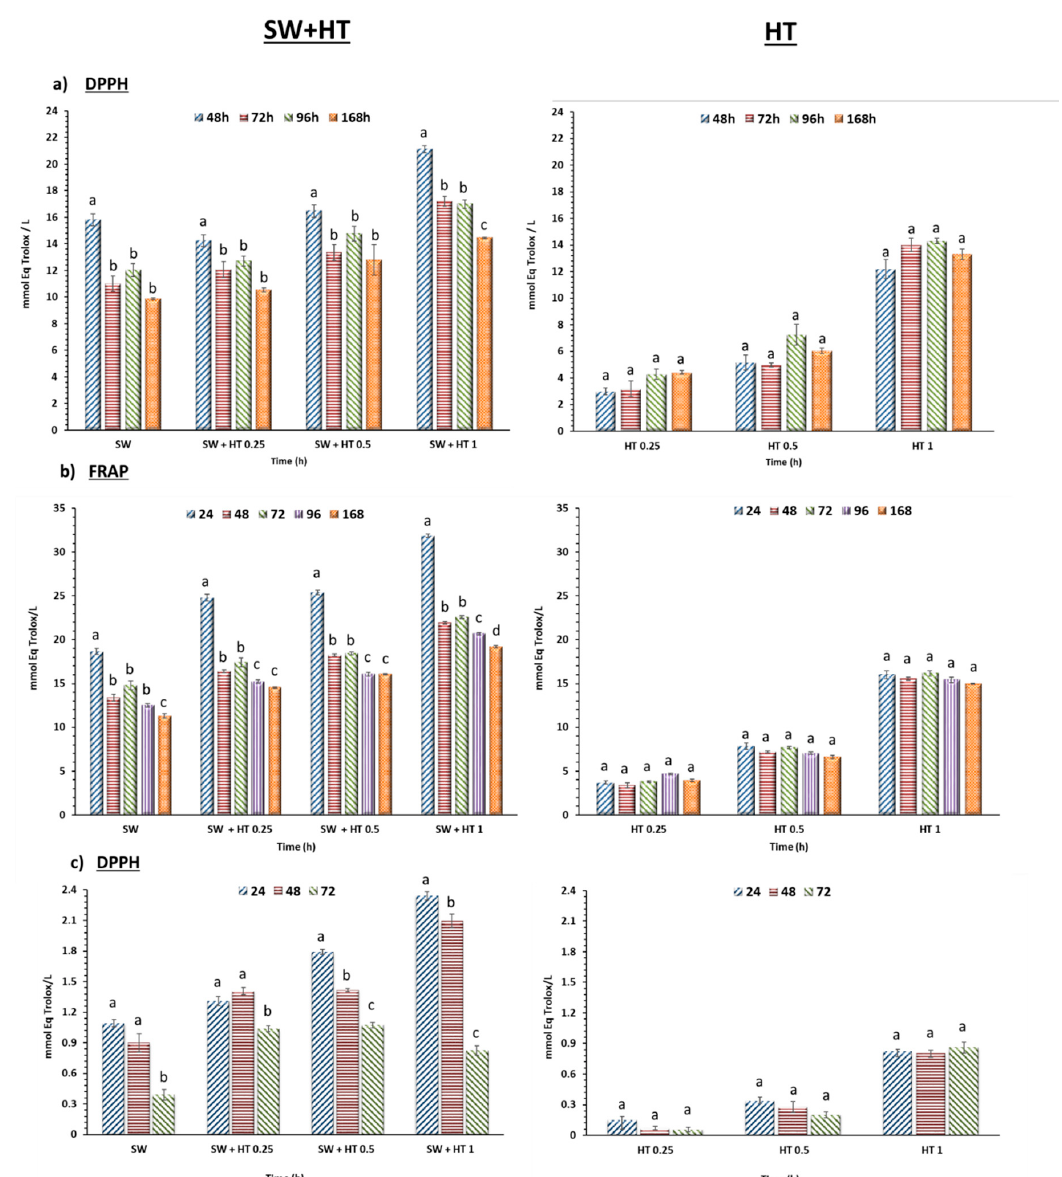
Figure 4. Antioxidant activity (mmol Eq Trolox/L) in the aqueous fraction obtained from the mixture of strawberry puree and hydroxytyrosol (SW+ HT) at 0.25, 0.5 and 1 mg/g fresh strawberry, and comparison with the activity of strawberry puree without added HT and the HT solution in an amount equivalent to that present in the mixture by the DPPH ( a ), and FRAP ( b ) and DPPH of the mixture of strawberry puree and hydroxytyrosol ( c ). The DPPH method was used, in which the strawberry puree (100 mg) was suspended in 7 mL of the DPPH reagent (3.8 mg/50 mL methanol). The data are shown as mean ± SD of quadruplicates. Letters (a–d) indicate significant differences among groups at p < 0.05. SW